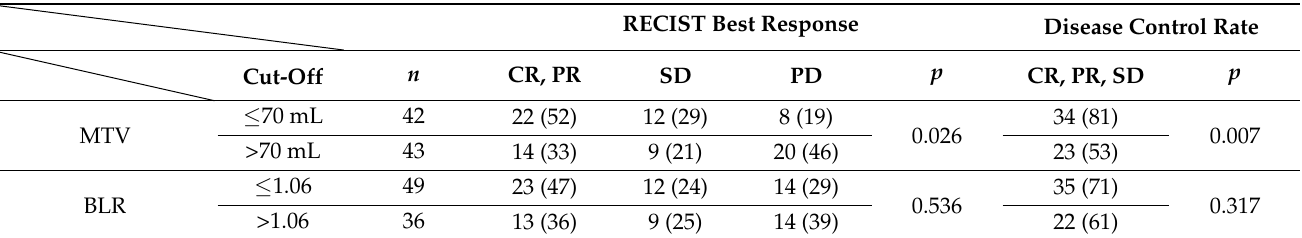
Table 3. Radiological best response and disease control rate according to RECIST. RECIST = Response Evaluation Criteria in Solid Tumors, CR = complete remission, PR = partial remission, SD = stable disease, PD = progressive disease, MTV = metabolic tumor volume, BLR = bone marrow to liver ratio.